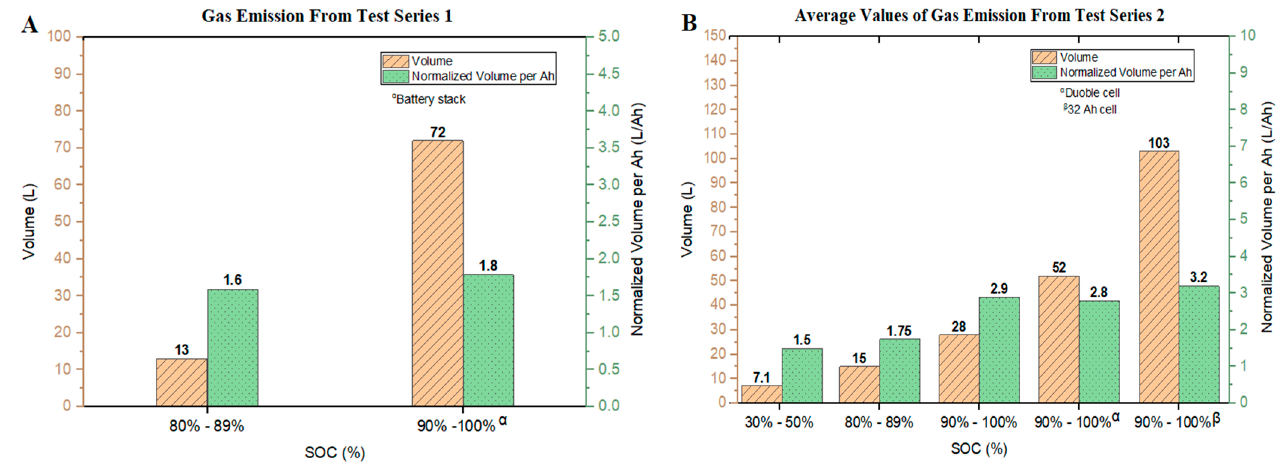
Figure 4. Volume and normalized volume of gases released versus the SOC of: ( A ) Series 1 tests; ( B ) Series 2 tests.